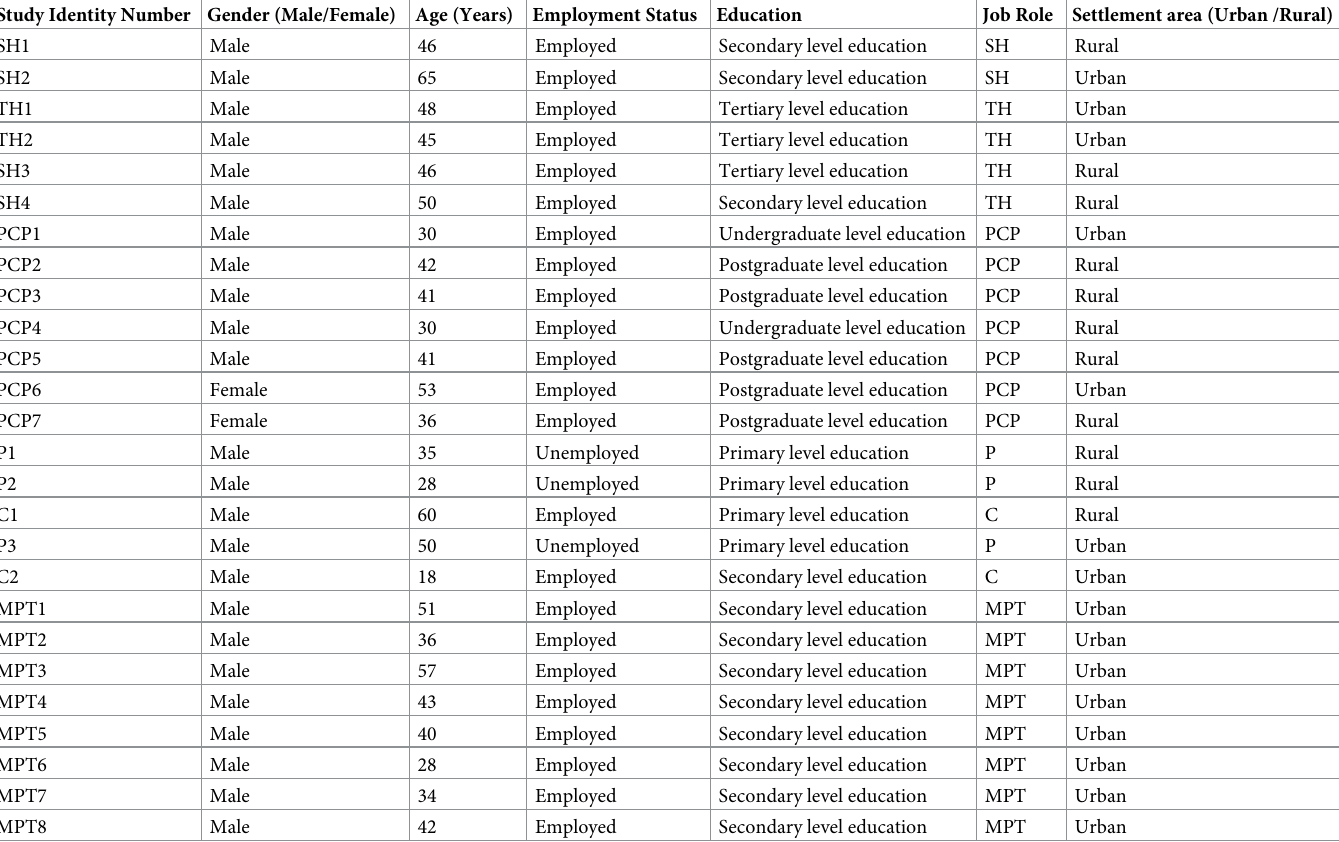
Table 1. Demographic characteristics of focus group discussion